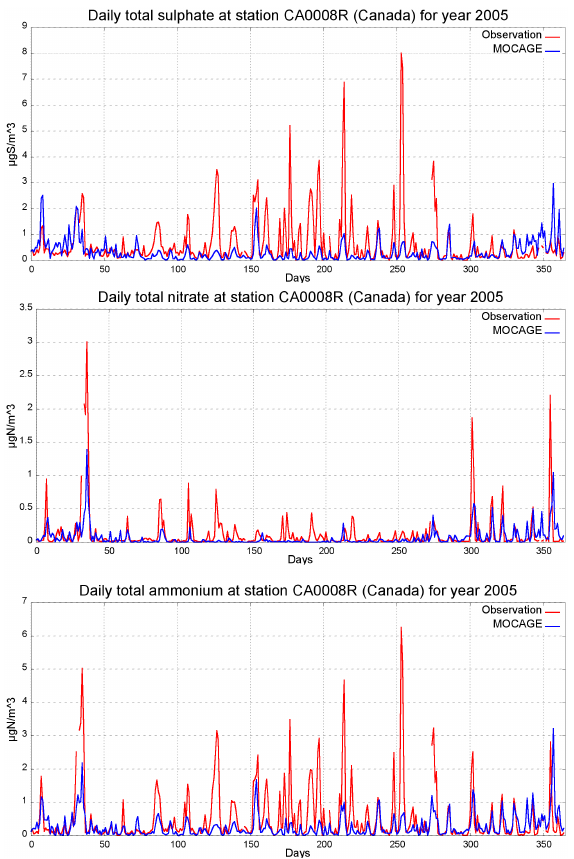
Figure 8. Time series of daily values (in µgm − 3 ) of sulfate (top panel), nitrate (middle panel) and ammonium (bottom panel) at a Canadian station (47 . 03 ◦ N, − 84 . 38 ◦ W) against the RACMSIA simulation for the year 2005.